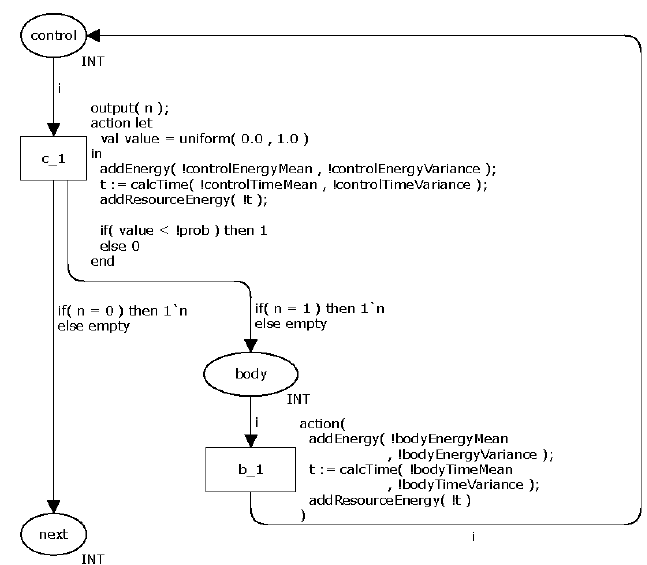
Figure 5. CPN model of the command while .